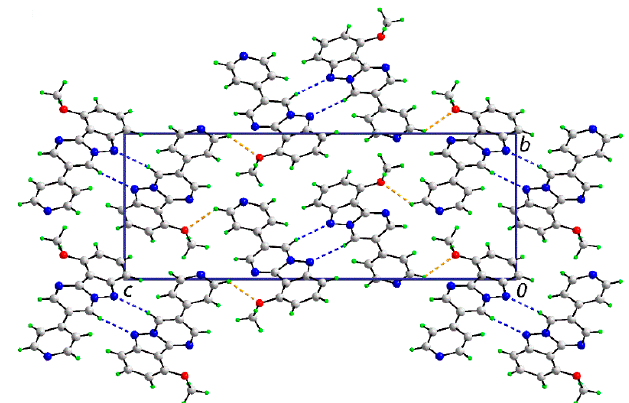
Figure 3. A view of the unit-cell contents for 1c in projection down the a -axis. The C–H ··· O and C–H ··· N are shown as orange and blue dashed lines, respectively.